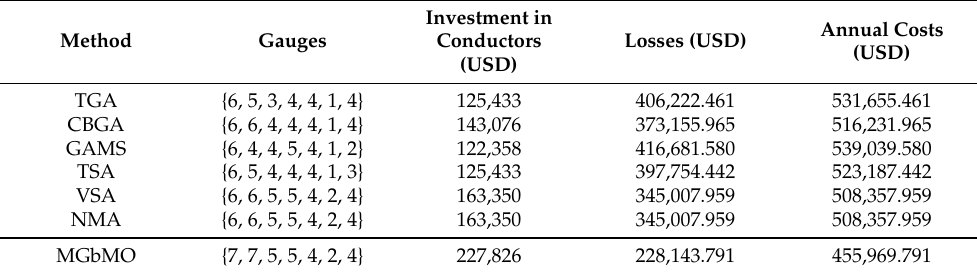
Table 9. Numerical results for the IEEE 8-bus system